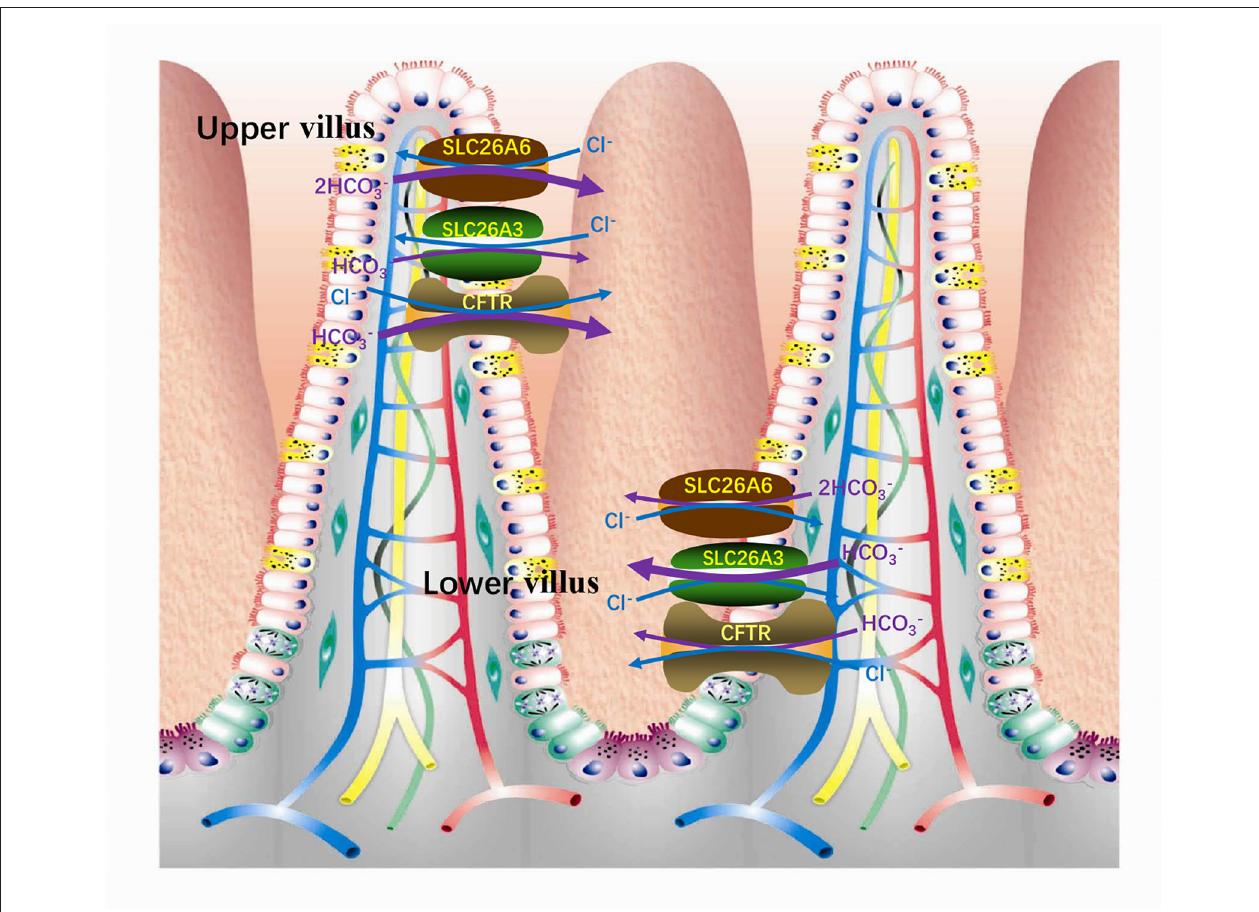
FIGURE 4 | In the small intestinal villi epithelium, SLC26A6 is predominantly responsible for the basal HCO − 3 secretion of the upper villi, while SLC26A3 is responsible for the lower